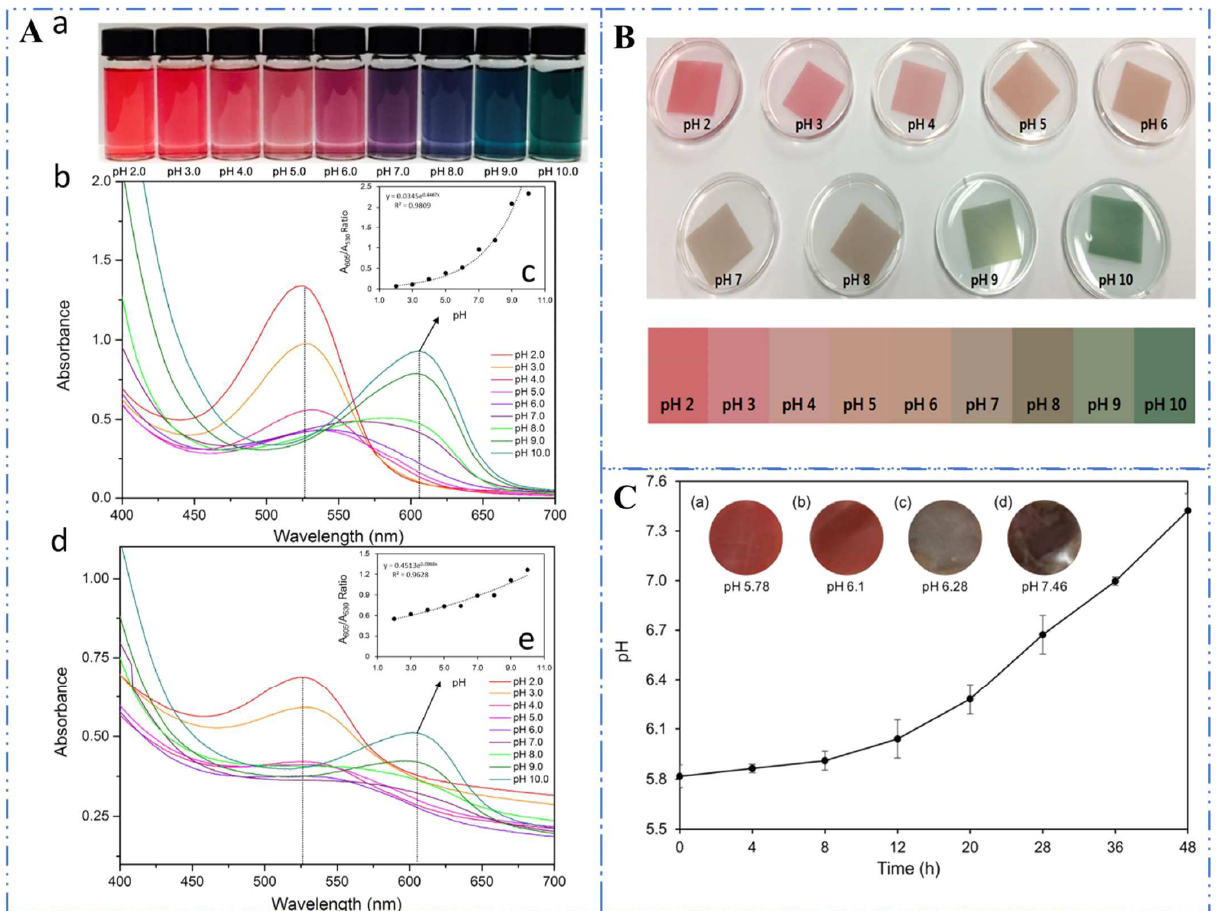
Figure 5. The scheme of a new colourimetric pH indicator film for the quality of pork. ( A ) Colour changes in PSPE solutions and intelligent films with PSPE. ( a ) Colour changes of PSPE solutions. ( b ) UV–vis spectra of PSPE solutions. ( c ) The absorbance ratio at 605 nm versus 530 nm of PSPE solutions. ( d ) UV–vis spectra of pH indicator films. ( e ) The absorbance proportion at 605 nm versus 530 nm of pH indicator films containing PSPE. ( B ) Colour changes in colourimetric intelligent pH indicator films dipped in various pH buffer solutions. ( C ) The curve of pH variations of pork samples and colour changes in intelligent pH indicator films of pork samples under accelerated storage conditions (25 ◦ C) for various periods [73]. Reproduced with permission from Choi, I, Food Chem. ; published by Elsevier,